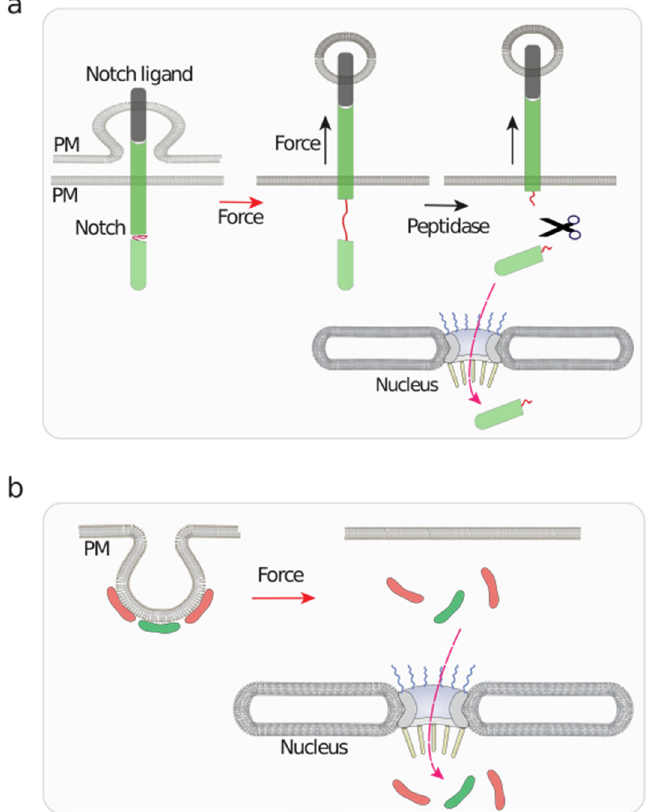
Figure 5. A graphical representation of mechanosensitive events taking place at the plasma membrane with implications in nuclear functions. ( a ) Notch binding to its ligand initiates an endocytic process of the ligand, which exerts a pulling force on bound Notch. This stretching action unfolds Notch, unmasking cryptic peptidase sensitive sites, which triggers the release of a Notch fragment that is translocated to the nucleus to regulate gene expression [131]. ( b ) Caveolae are mechanosensitive plasma membrane (PM) invaginations that undergo flattening upon osmotic swelling [14,132,133]. This triggers the release, and subsequent nuclear translocation of EHD2 and Cavin3, represented as red and green modules, respectively, which regulate nuclear function [134].